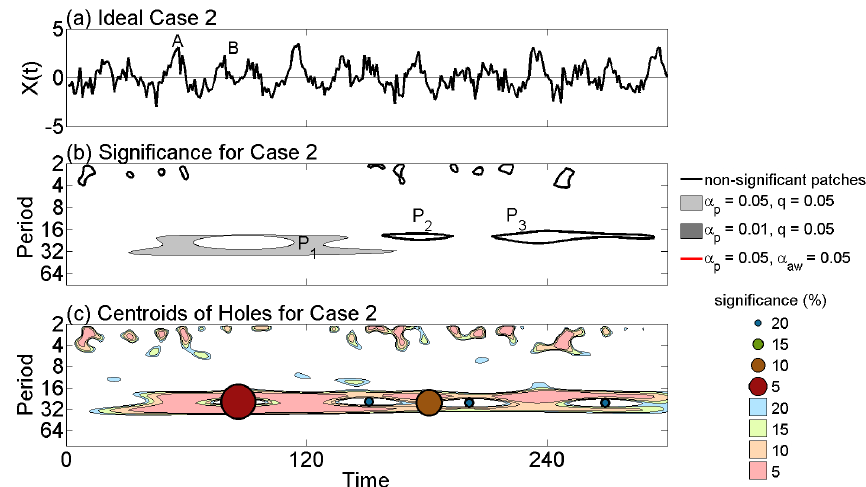
Figure 9. (a) Time series of Case 2. Gaussian additive white noise with a signal-to-noise ratio of 8 was added to the time series. At the point labeled “A”, two oscillations resonate, merging two pointwise significance patches in the wavelet domain. At the point labeled “B” no such resonance occurs and the two significance patches separate. (b) The significance of wavelet power (see Fig. 3 for details). The pointwise significance patch labeled P 1 contains a hole and the pointwise significance patches labeled P 2 and P 3 were falsely deemed insignificant by the geometric and areawise tests. (c) Same as Fig. 8c except for Case